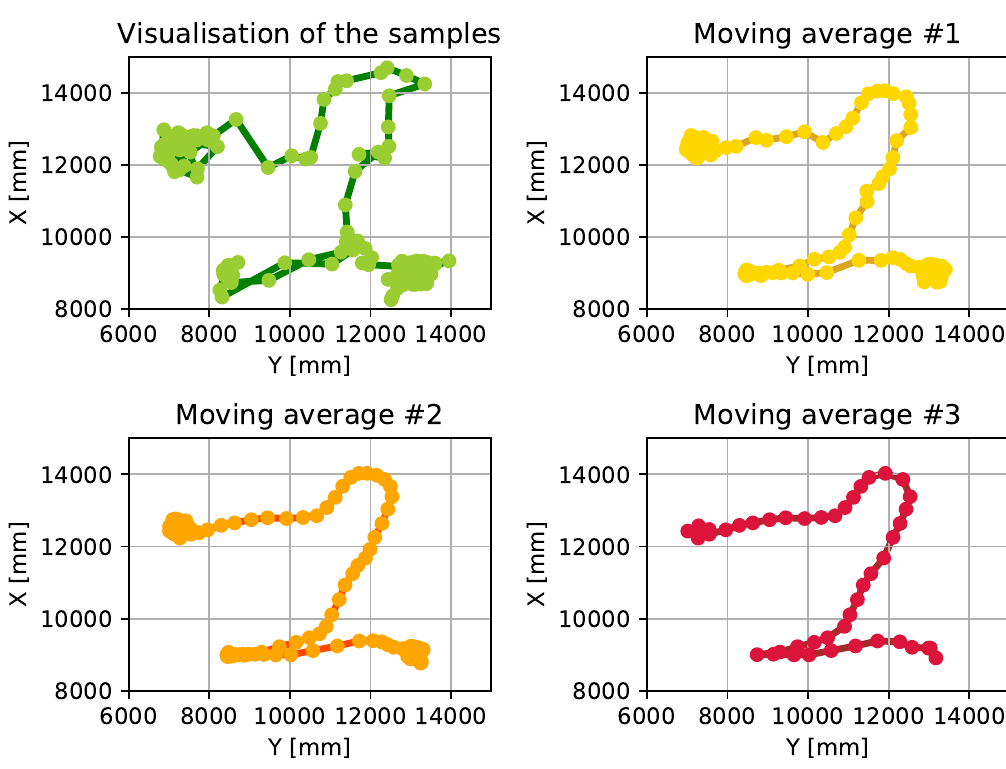
Figure 11. Using moving average with different window sizes on a path tracked by a moving